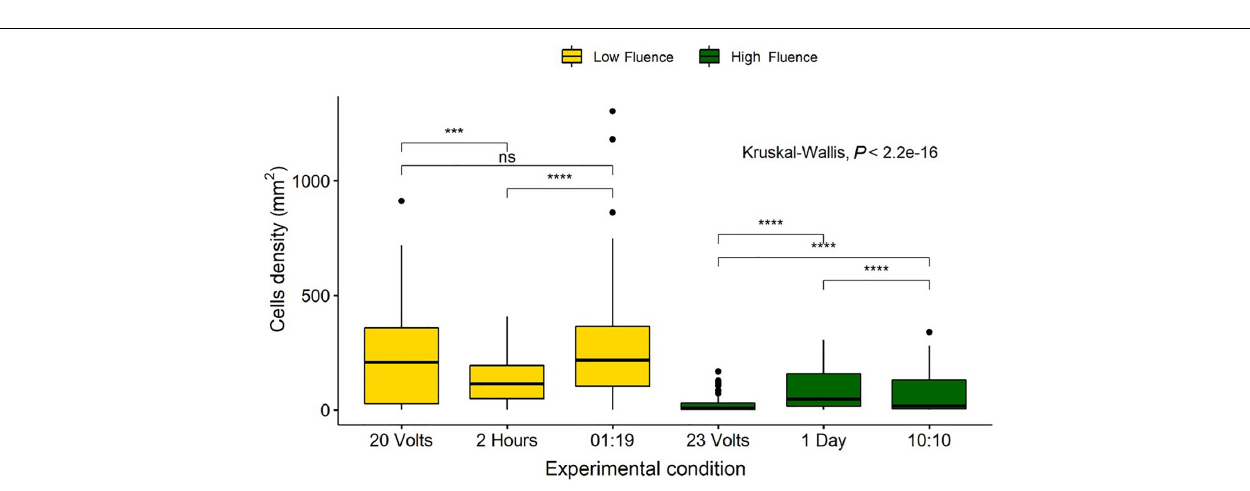
FIGURE 9 | Navicula incerta cell densities and ranges at different voltages, with the corresponding fluence on the x axis. Predictive generalized linear modeling indicated the intercept between irradiated density and initial density to be between 20 and 21 volts (0.82–2.65 J/cm 2 ).